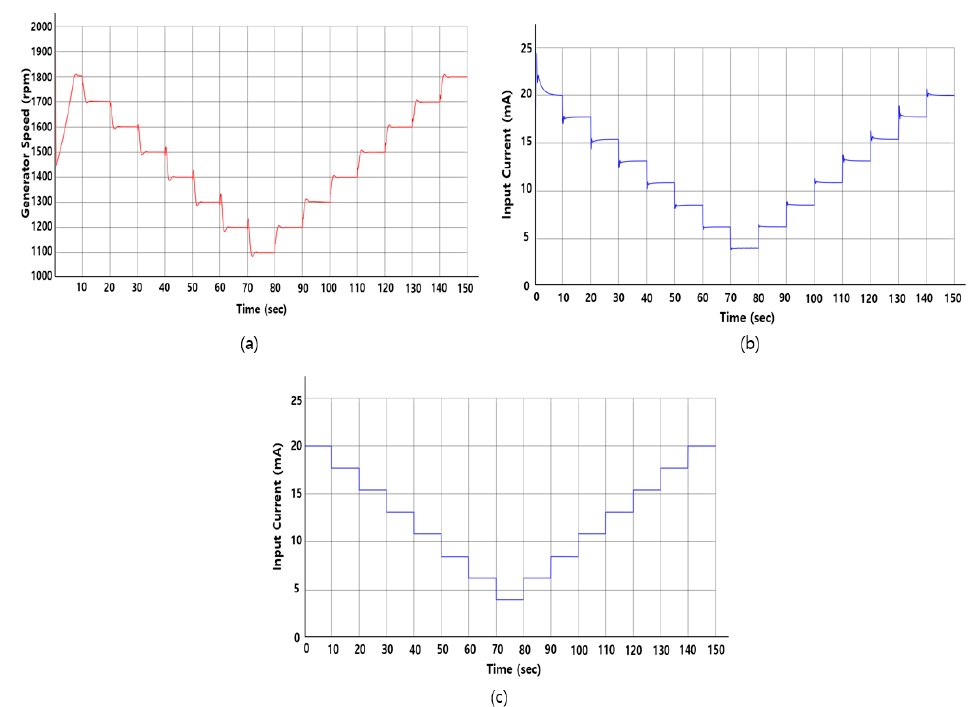
Figure 9. ( a , b ) Input/output training data for the neural network and ( c ) training output result with respect to time.